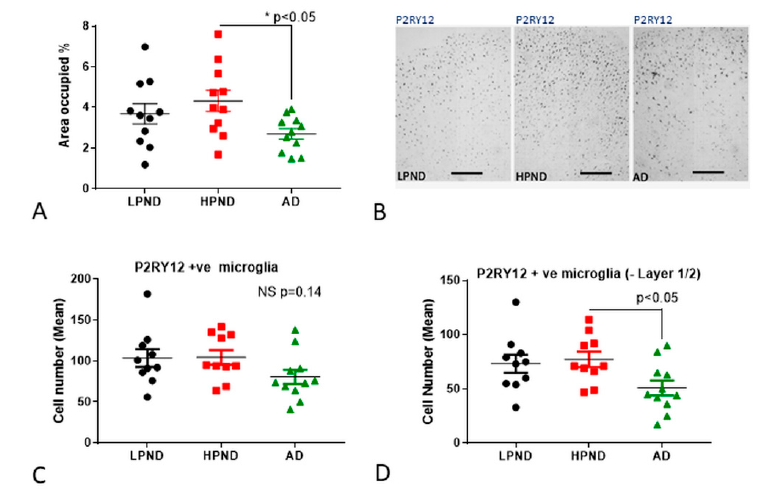
Figure 4. Quantitative measurements of P2RY12 immunoreactive structures in human brain tissue sections. ( A , B ). Measurements of area occupied of P2RY12 immunoreactivity in LPND ( n = 11) (black), HPND ( n = 11) (red) and AD ( n = 12) (green) cases. ( A ). Sections were imaged at 4x magnification (three random areas / cases) and area occupied in thresholded images measured using Image J software. Results show significant decrease between HPND and AD cases. Statistical analysis by one-way ANOVA with Tukey post-hoc test (F 2,29 = 3.903, p < 0.05). ( B ). Representative images of low magnification images of LPND, HPND and AD used for measurements show distribution of P2RY12 immunoreactive microglia. Scale bars represent 400 µ m. ( C ). Numbers of P2RY12 immunoreactive microglia in all cortical layers. Scatter plot showing the estimated total mean number of microglia in cortical layers I–VI. Individual points represent the mean of total numbers from three separate measures for each slide. The numbers of microglia / 2 mm 2 field were counted. Results show insignificant decline in mean number of P2RY12-positive microglia in AD cases. Statistical analysis by one-way ANOVA with Tukey post-hoc test (F 2,29 = 1.704, p = 0.14). ( D ). Numbers of P2RY12 immunoreactive microglia in cortical layers III-VI. Scatter plot showing the estimated total mean number of microglia in cortical layers III-VI. The numbers of microglia counted in Layers I and II were subtracted from the total. Individual points represent the mean of total numbers (except Layers I and II) from three separate measures for each slide. The numbers of microglia / 2 mm 2 fields were counted. Results show significant decline in mean number of P2RY12 positive microglia in AD cases. Statistical analysis by one-way ANOVA with Tukey post-hoc test (F 2,29 = 3.201, p < 0.05). Abbreviations : LPND: low plaque non-demented. HP: